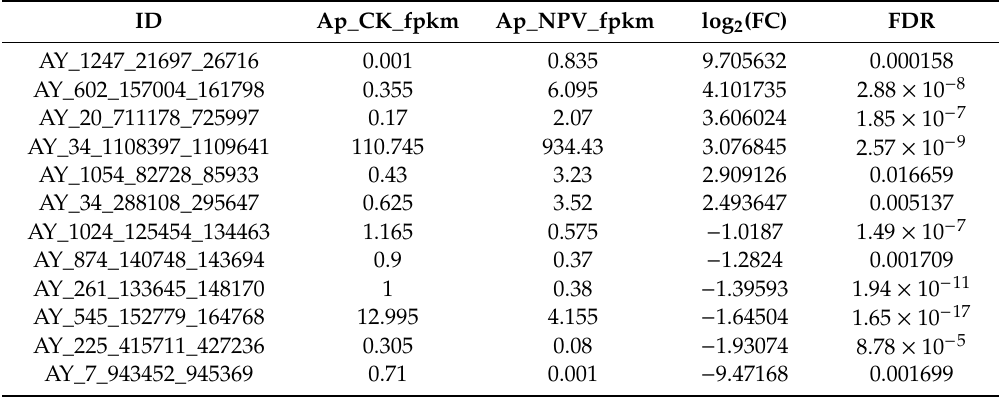
Table 2. DELs that are di ff erentially expressed during ApNPV